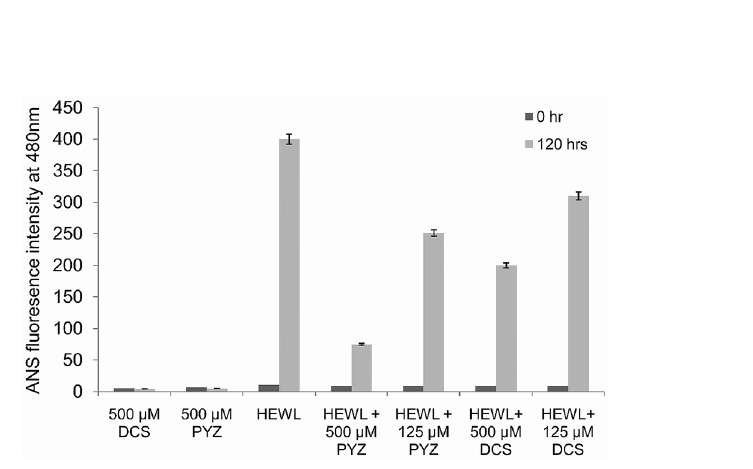
Fig 7. ANS fluorescence intensity measurements of HEWL in absence and presence of PYZ and DCS. The 500 μ M each of PYZ and DCS were taken as control.